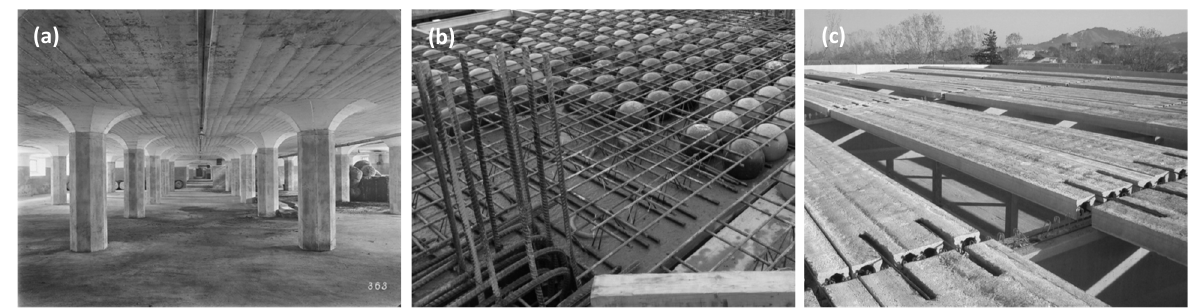
Figure 2 . Examples of solid and hollow floor slabs: (a) Mushroom slab of warehouse Giesshübel, Zürich (1910, Photo: ETH ‐ Bibliothek, Hochschularchiv, Hs 1085: 1910 ‐ 3), (b) Bubble deck system (Photo: Bubbledeck North America), (c) hollow ‐ core slab elements (Photo: Nordimpianti).